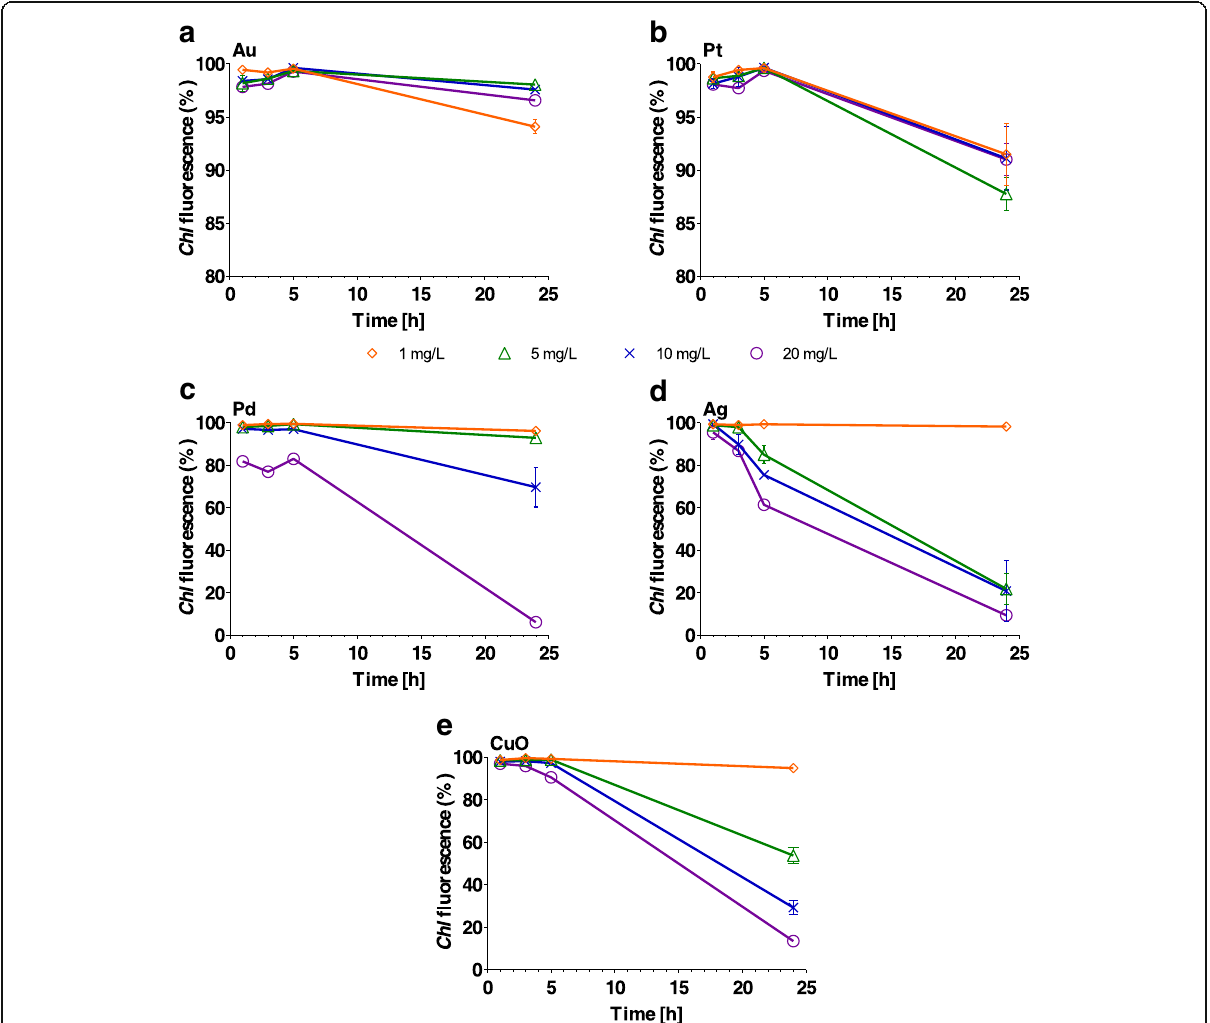
Fig. 5 Percentage of Chlamydomonas reinhardtii cells with chlorophyll ( Chl ) fluorescence following exposure to increasing concentrations (1, 5, 10 and 20 mg/L) of a Au, b Pt, c Pd, d Ag and e CuO nanoparticles after 1, 3, 5 and 24 h. The error bars represent the standard deviation of repeated experiments using duplicate